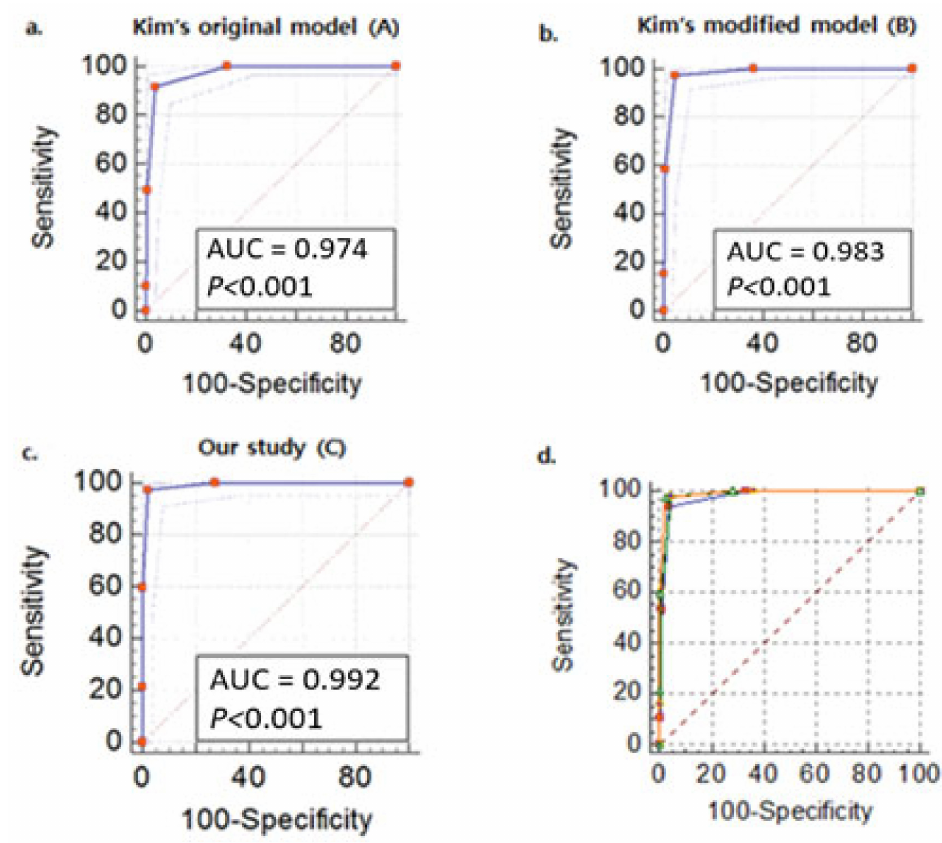
Figure 1. Receiver operating characteristic (ROC) curves of the multivariable logistic regression models ( a ). Model A: altered mental status, leukopenia, prolonged activated partial thromboplastin time (aPTT), normal C-reactive protein (CRP) level ( ≤ 1.0 mg/dL), ( b ). Model B: altered mental status, leukopenia, prolonged aPTT, normal CRP level ( ≤ 3.0 mg/dL), ( c ). Model C: leukopenia, prolonged aPTT, normal CRP level ( ≤ 3.0 mg/dL), elevated creatine kinase level (>1000 IU/L), ( d ) square: model A, circle: Model B, triangle: Model C for the severe fever with thrombocytopenia syndrome predictive